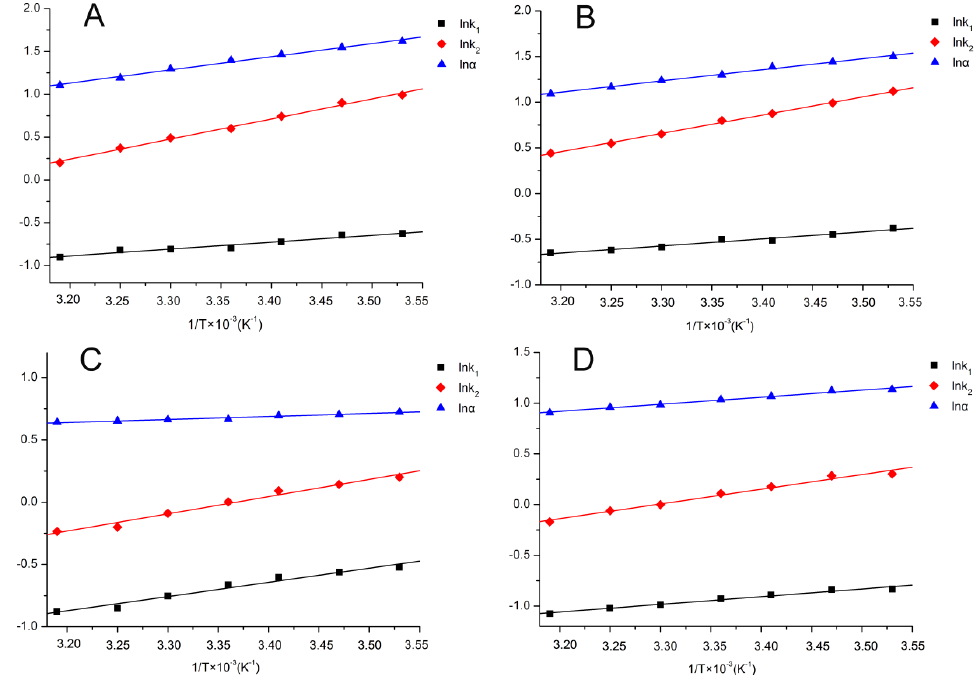
Figure 3. Van’t Ho ff plots of etoxazole on Chirapak IC chiral column (( A ) HEX / IPA = 70 / 30, ( B ) HEX / BuOH = 60 / 40, ( C ) MEOH / H 2 O = 90 / 10, and ( D ) ACN / H 2 O = 80 / Figure 3. Van ’t Hoff plots of etoxazole on Chirapak IC chiral column (A HEX/IPA = 70/30, B HEX/BuOH = 60/40, C MEOH/H 2 O = 90/10, and D ACN/H 2 O = 80/20).